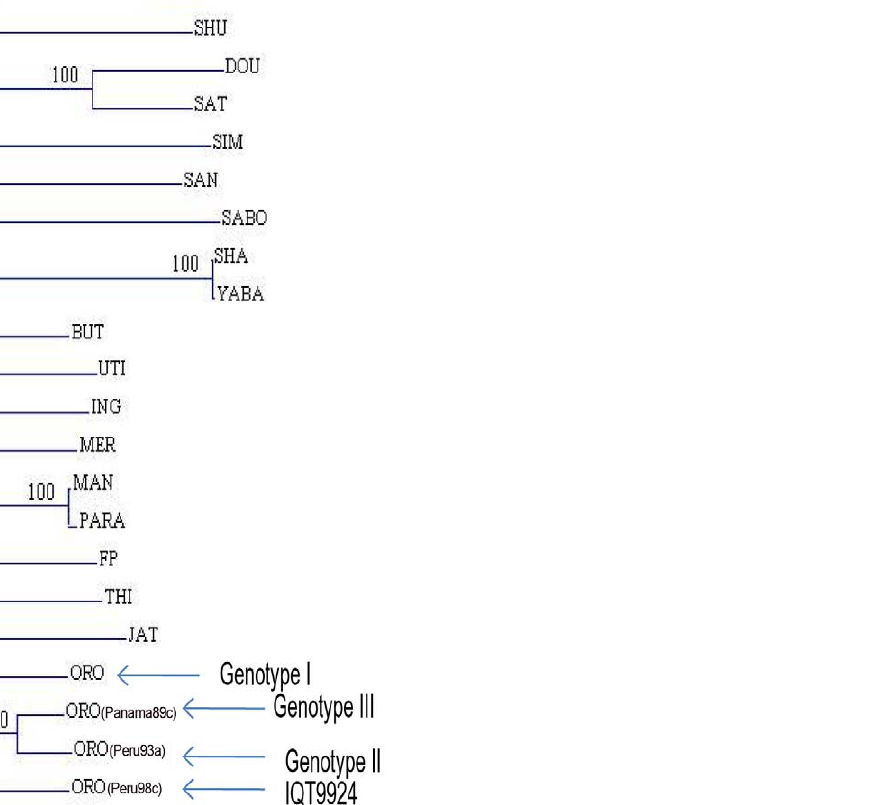
Figure 2. Neighbor-joining phylogenetic tree of the M segment RNA of members of the Simbu serogroup. The tree was constructed based on partial sequences of the Gc gene. Bootstrap values were obtained based on 500 replicates. Virus abbreviations are as follows: Kai, Kaikalur; Shu, Shuni; Dou, Douglas; Sat, Sathuperi; Sim, Simbu; San, Sango; Sha, Shamonda; But, Buttonwillow; Uti, Utinga; Ing, Ingwavuma; Mer, Mermet; Man, Manzanilla; FP, Facey’s Paddock; Thi, Thimiri; Jat, Jatobal; ORO, Oropouche.